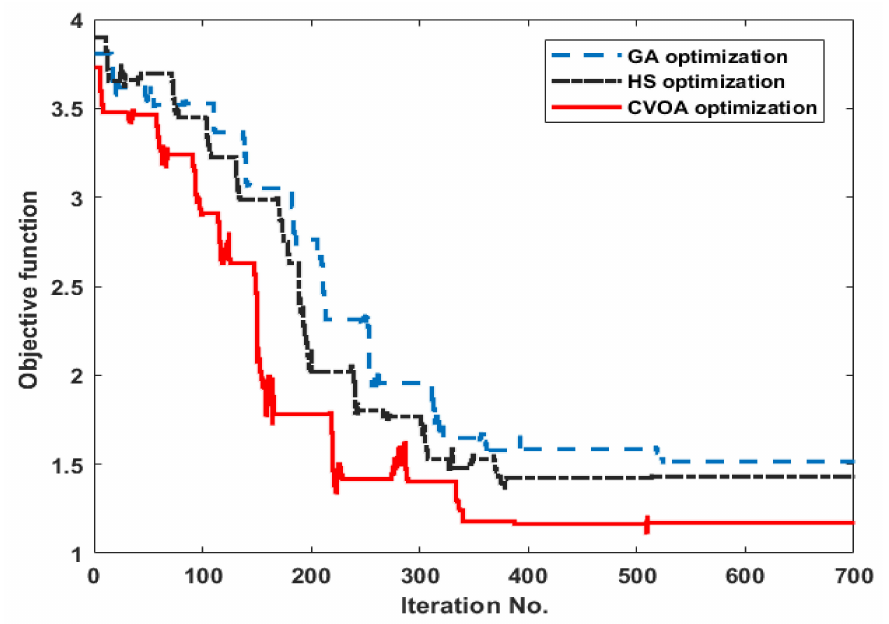
Figure 5. The convergence curve for GA, HS, and